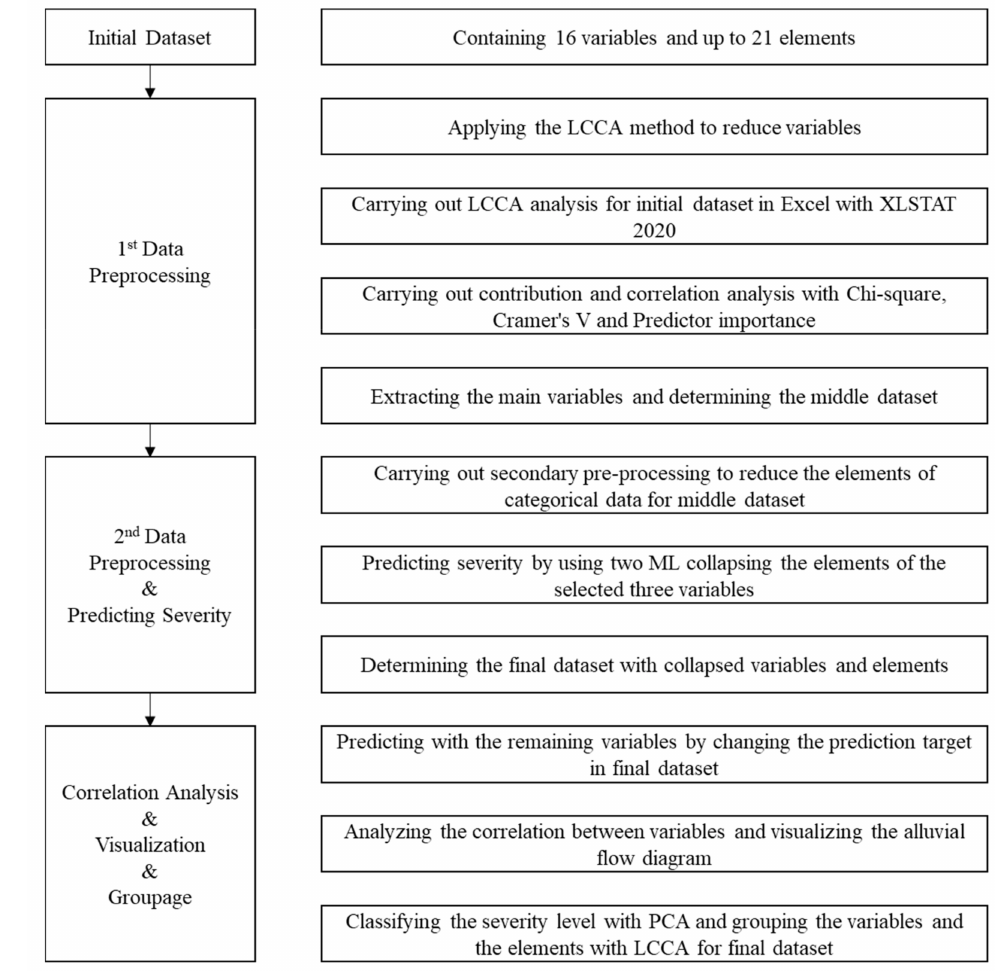
Figure 1. Research procedure and